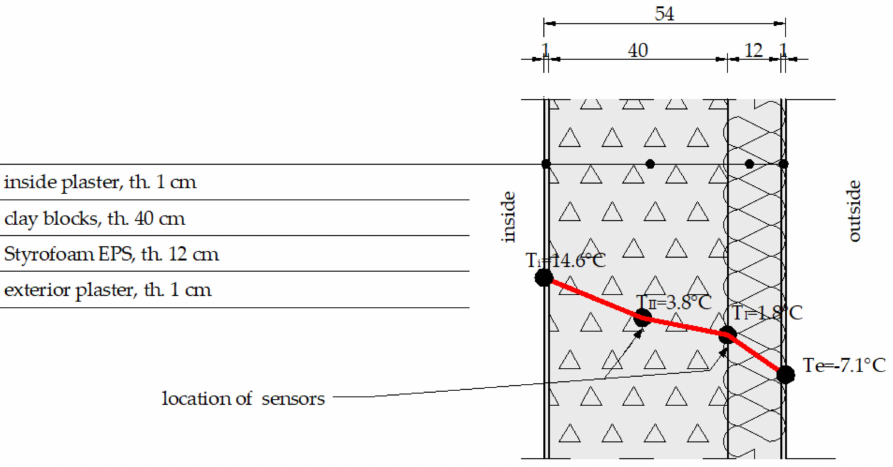
Figure 9. Temperature distribution in the building envelope during the thermographic camera measurement.